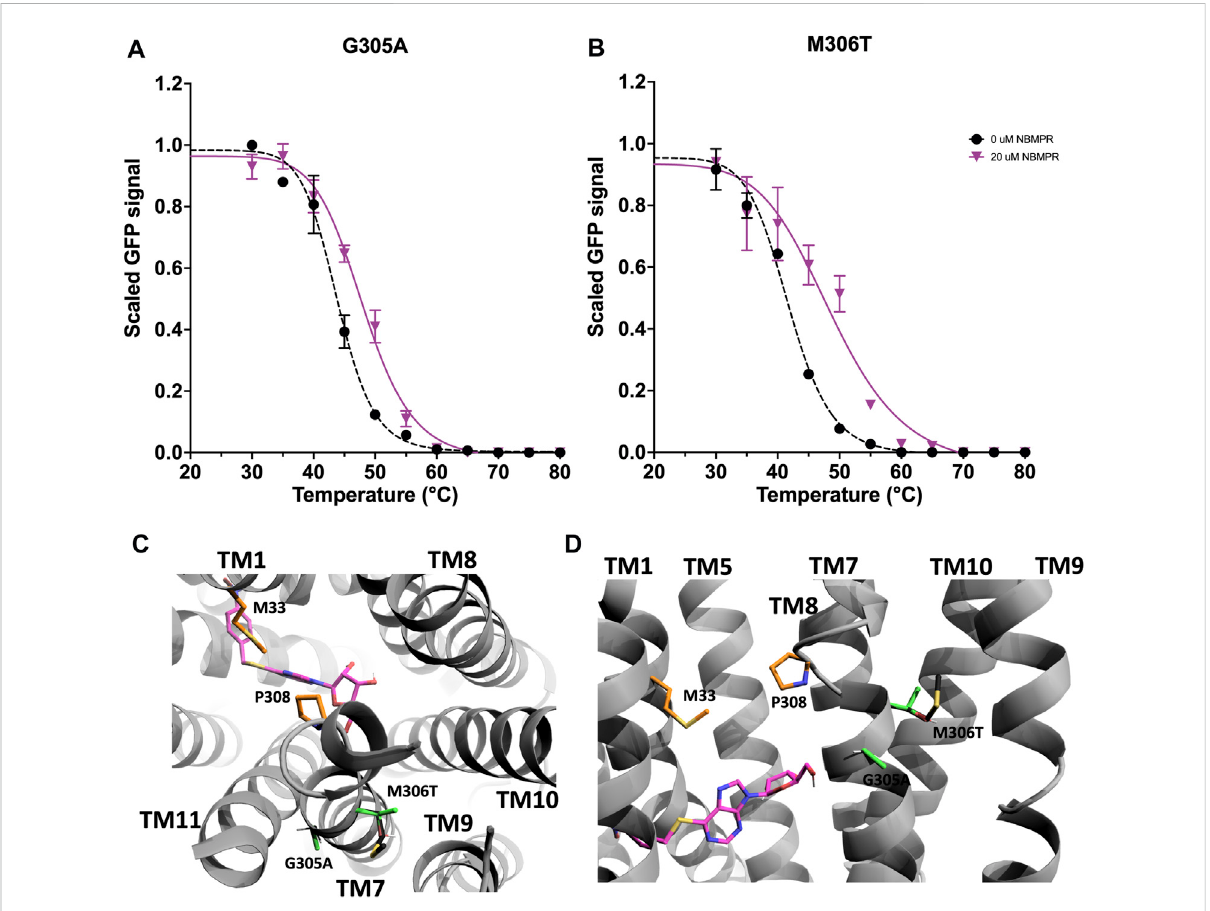
FIGURE 4 Investigation and rationalisation of variants G305A and M306T stabilisation of hENT1. Data generation, fi tting and error analysis performed as detailed in wild type. (A) G305A apo -state curves were collected as an average of 8 repeats, whereas NBMPR-bound curves were collected as an average of 3 repeats. (B) M306T apo -state curves were collected as an average of 5 repeats, whereas NBMPR-bound curves were collected as an averageof3repeats. (C) Atop-downand (D) aclose-upperpendicular viewintothecentralcavityofhENT1(TM11wasremovedinDforclarity). NBMPR is shown in pink. Residues involved in formation of the extracellular thin gate are shown in orange. Native residues are shown in black, and mutations are shown in